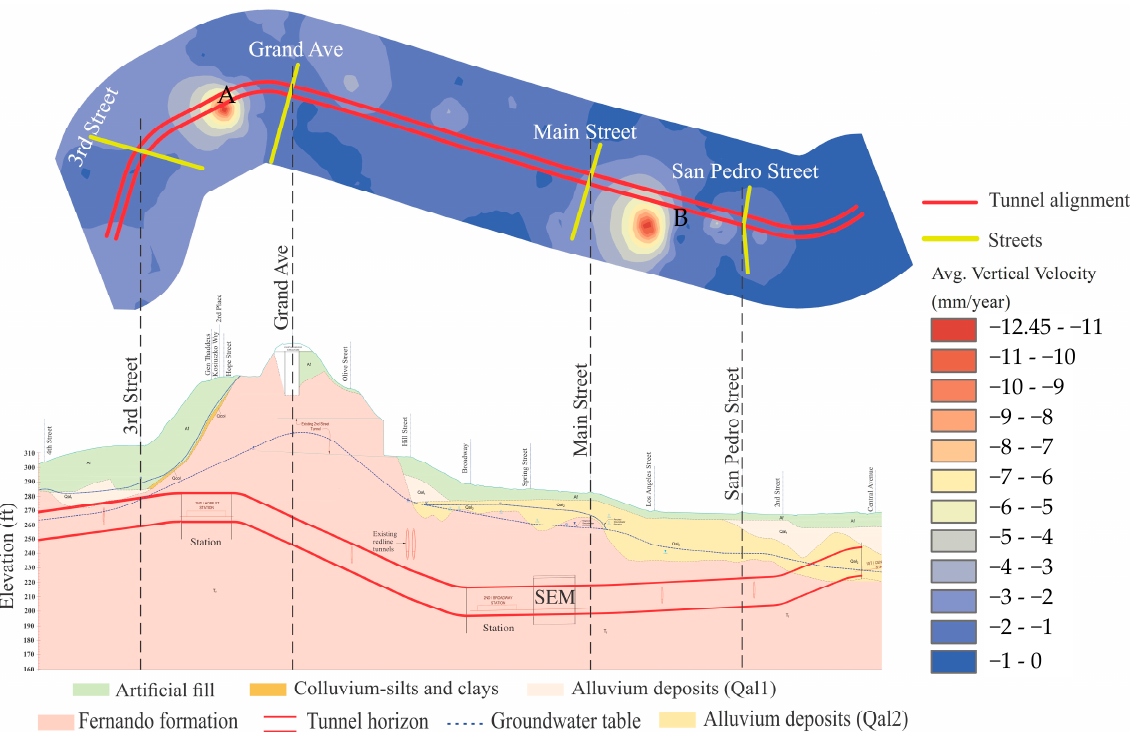
Figure 11. Ground settlement field (above figure) and corresponding geological conditions (below